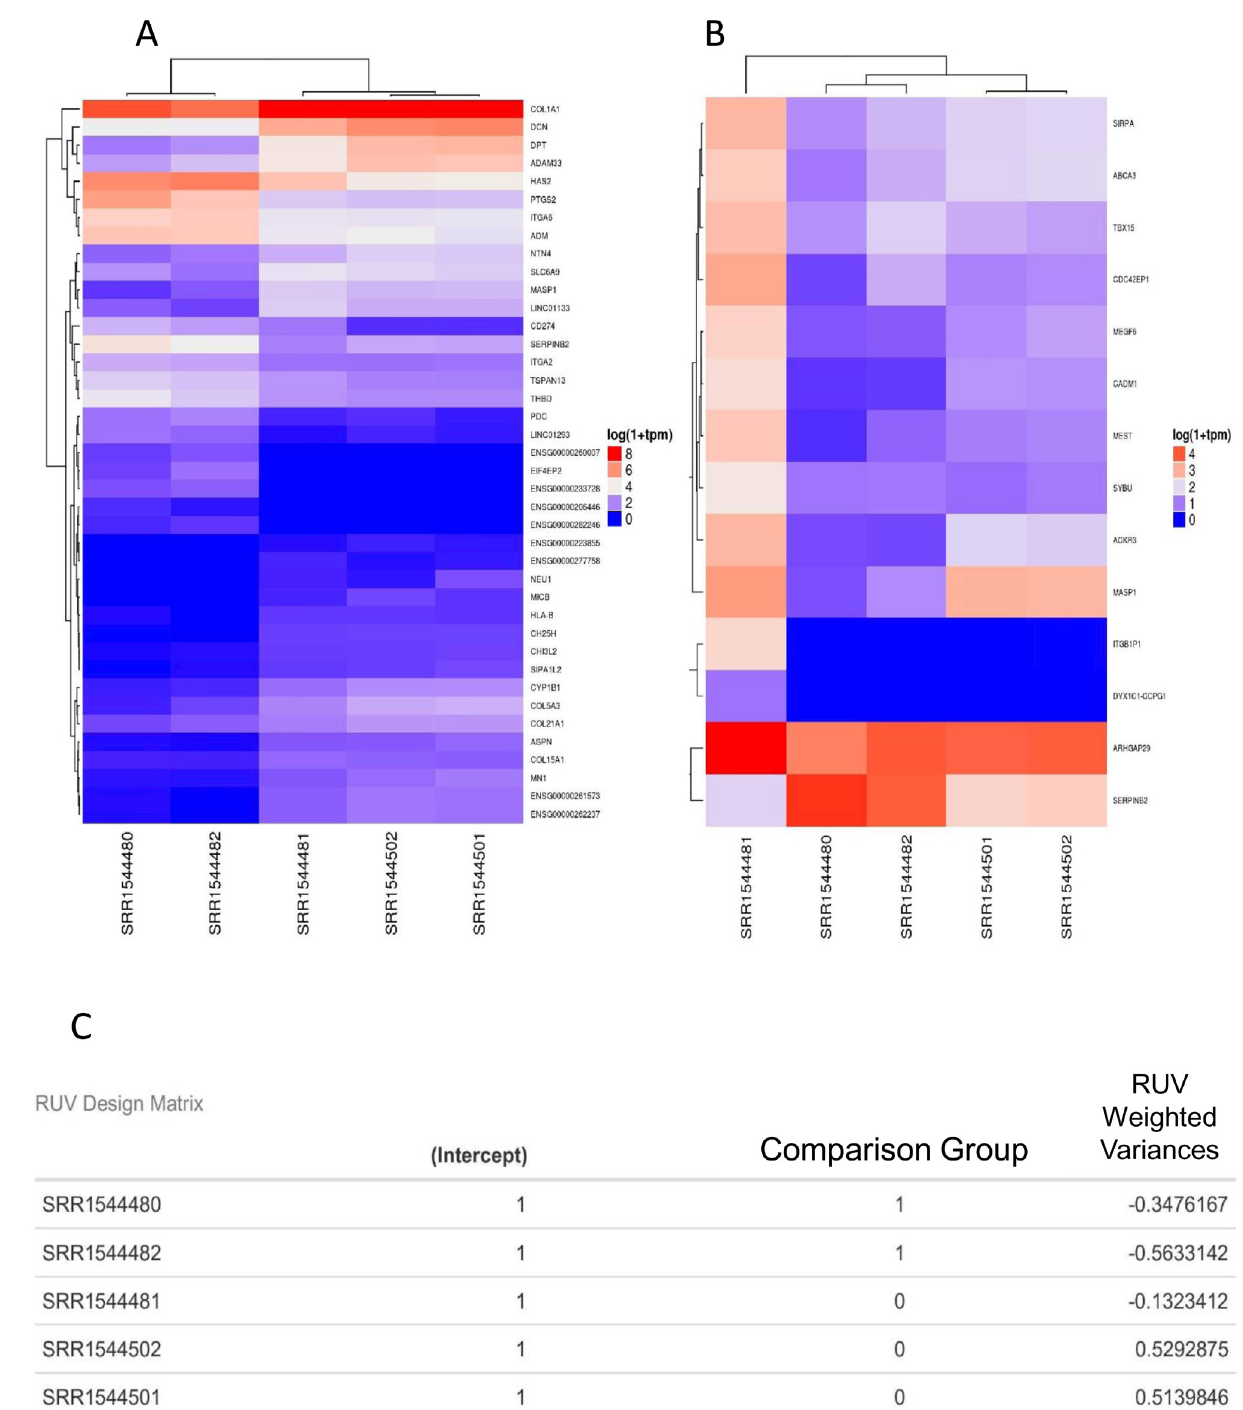
Figure 3. Arkas-Analysis Differential Expression Report: DE using TMM and RUV. A ) DE analysis using TMM normalization. The X-axis is the sample names (test data), the Y-axis are Gene symbols (HUGO). Expression values are plotted in log RUV normalization. C ) The design matrix with the RUV adjusted weights. The sample names are test data used in demonstrating the general analysis report